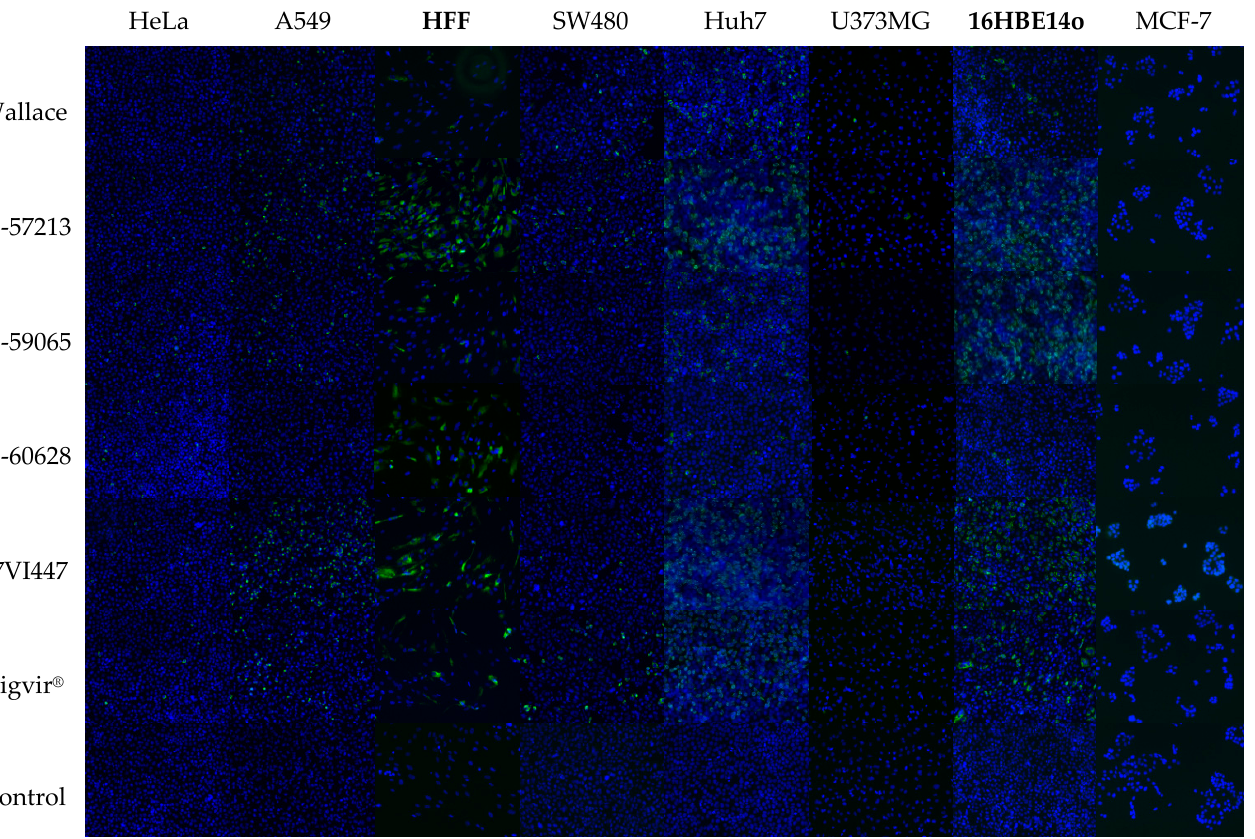
Figure 4. Immunofluorescence results of cell infection using TCID50 across six cancer and two native cell lines (bolded) with virus isolates used in this study. Rigvir ® is seen infecting both native and cancer cell lines, with an overall infection profile reminiscent of what is seen across clinical E7 isolates. MCF-7 cells are seen as non-infectious across all isolates in this study.